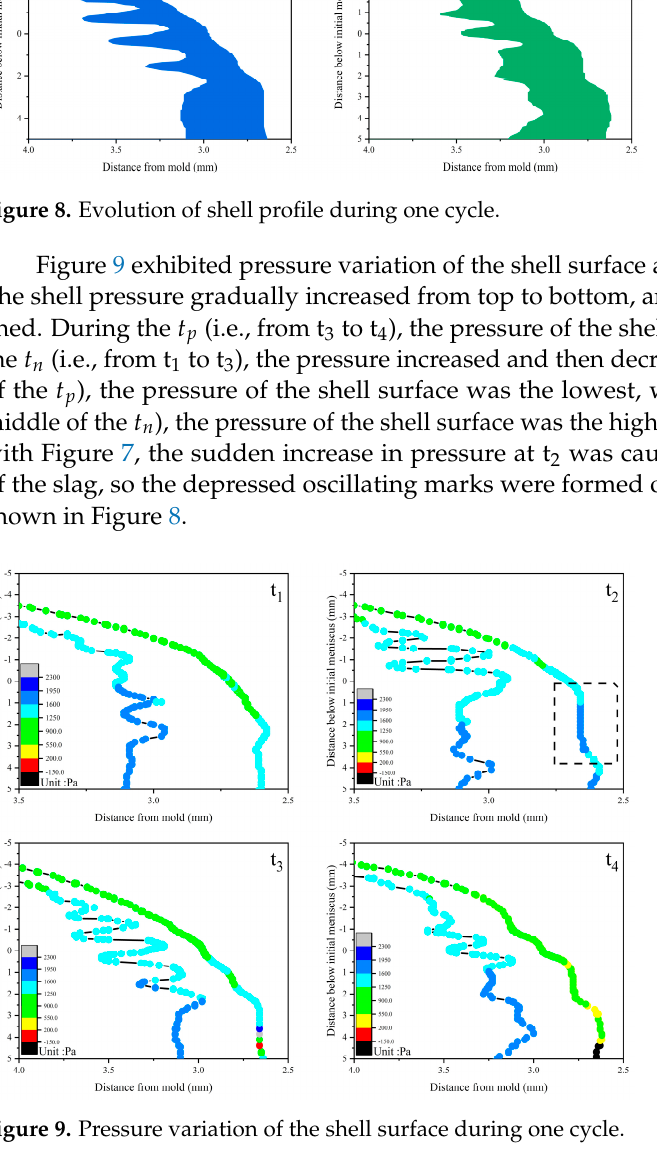
Figure 9. Pressure variation of the shell surface during one